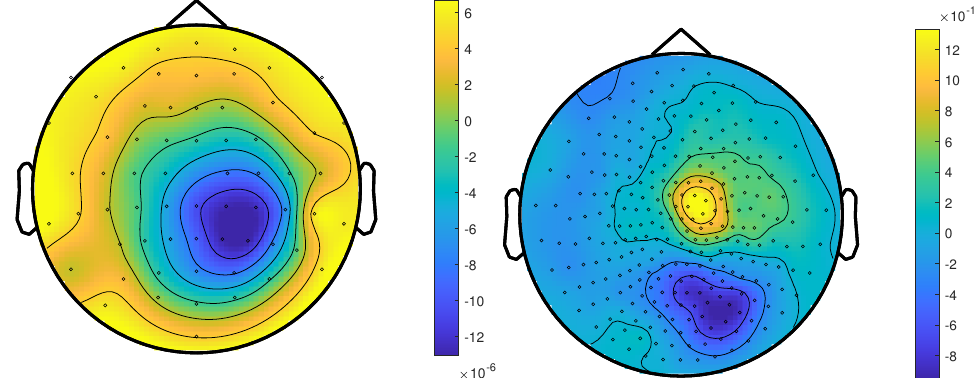
Figure 2. The topographic maps of patient 1, left EEG and right MEG, show the potential and field amplitudes with yellow for positive and blue for negative at the sensor level relative to the mean at the time point of the middle of the rising flank at − 6.6 ms. The sensors are interpolated to a sphere model that represents the